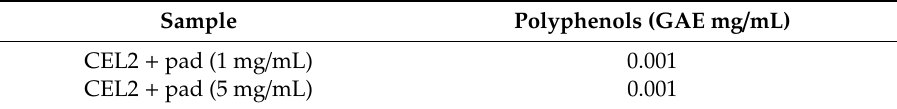
Table 2. CEL2 surface polyphenols amount after functionalization.